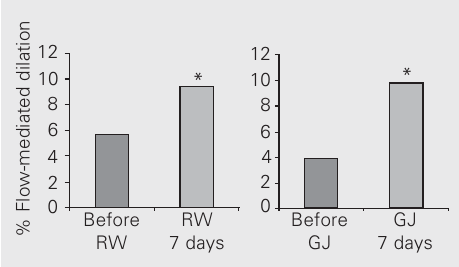
Figure 6. Red wine (250 ml/day) and grape juice (500 ml/day) for 7 days increase brachial artery flow-mediated dilation in 7 adult subjects of each group who had hypercholesterolemia, arterial hypertension and who smoked. *P < 0.05 compared to before treatment days (ANOVA). GJ = grape juice; RW = red wine. Re- produced from Ref. 56, with per-